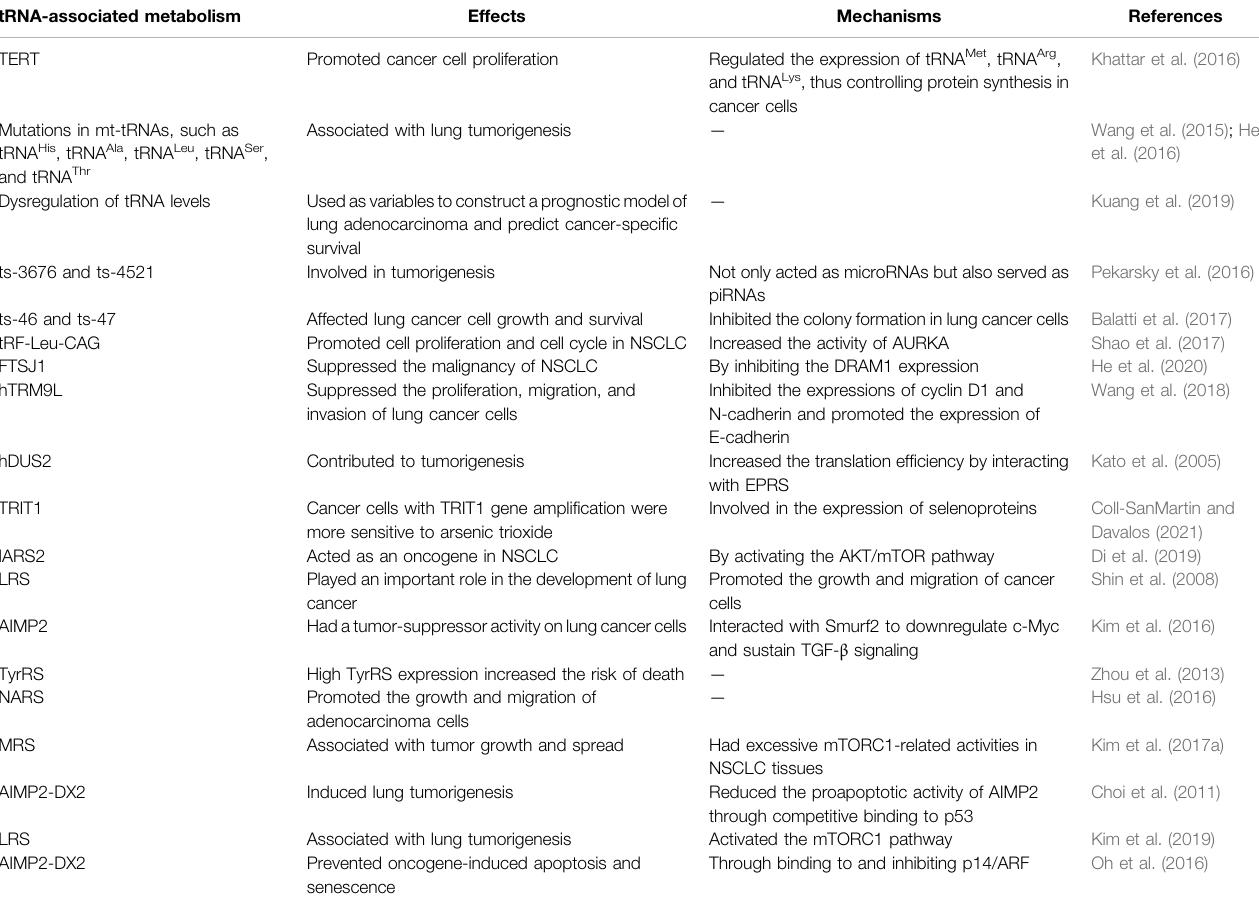
TABLE 1 | Roles of tRNA-associated metabolism in lung